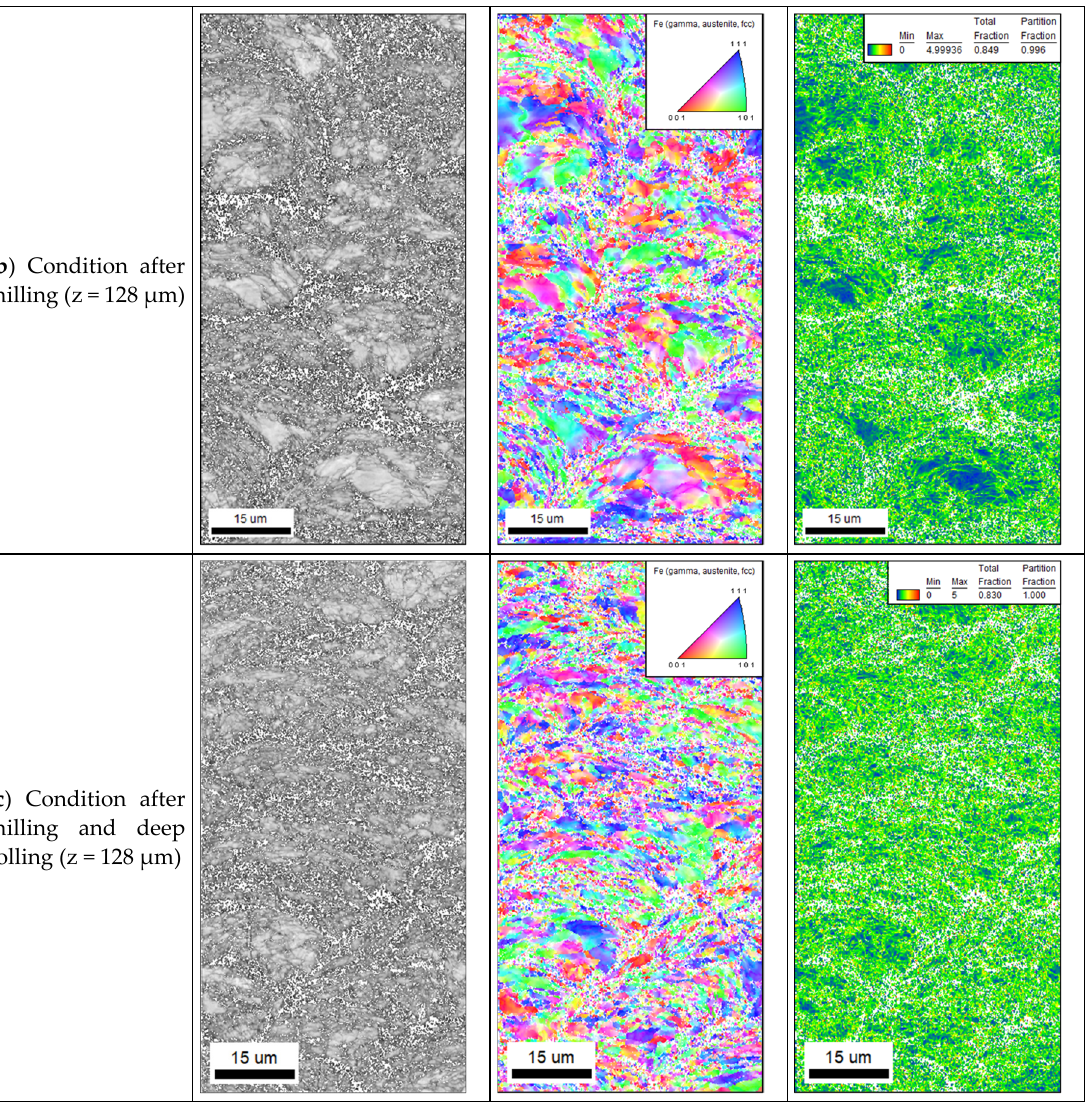
Figure 12. Image quality, inverse pole figure and Kernel Average Misorientation determined by EBSD measurements for ( a ) an unaffected reference condition, ( b ) a milled subsurface, and ( c ) a milled and deep rolled subsurface.